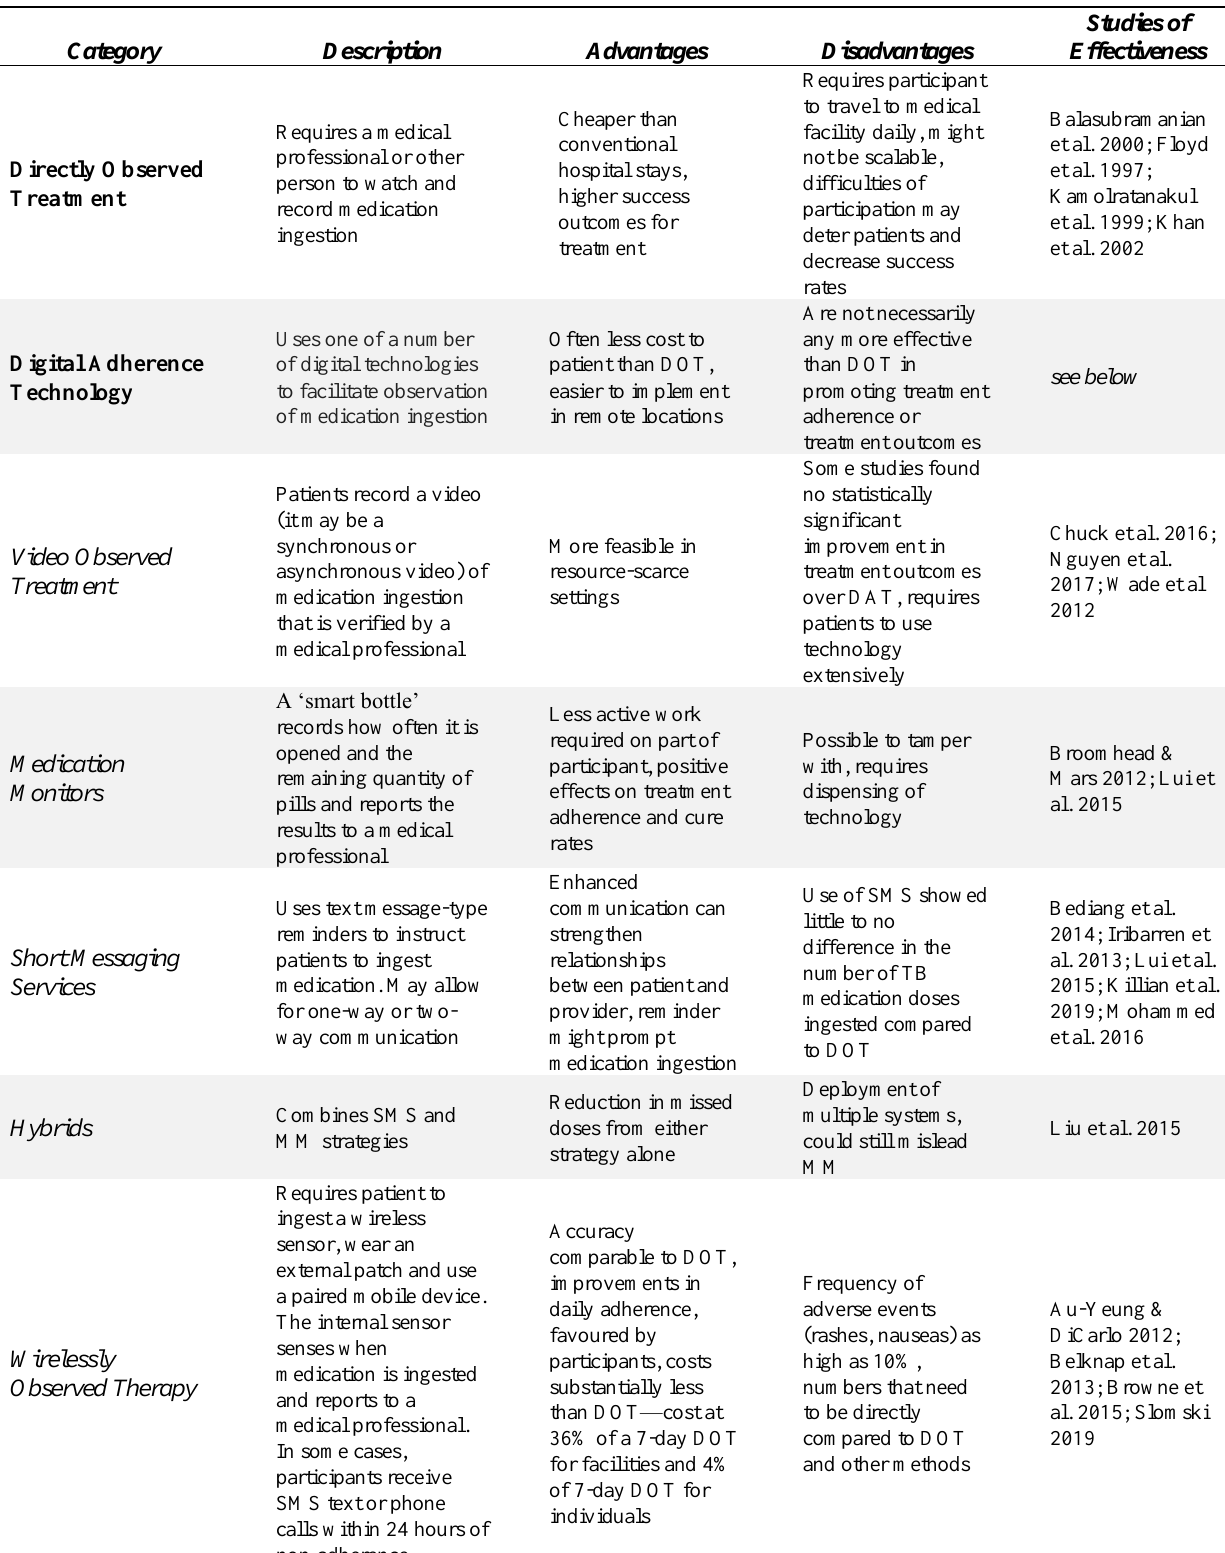
Table 3: Directly Observed Therapy (DOT) v. Digital Adherence Technology (DAT)